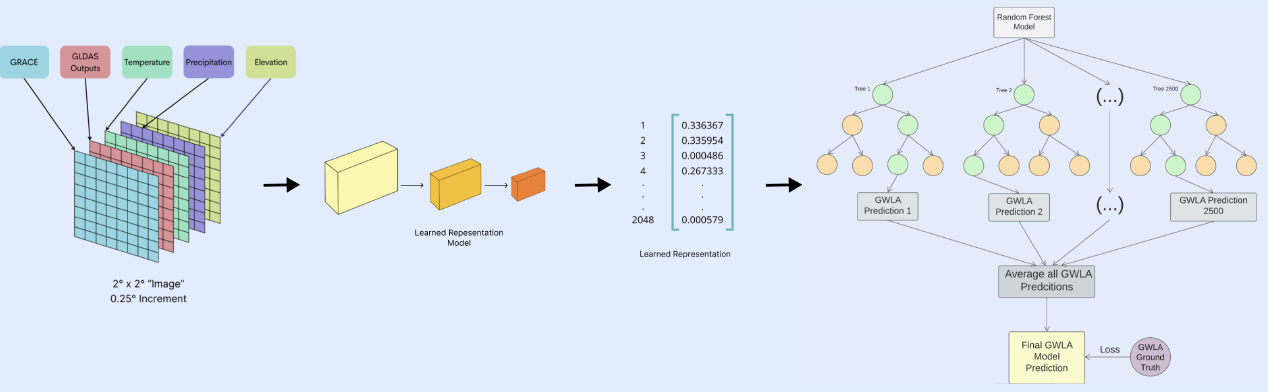
Figure 5. A satellite data “image” is fed into the trained unsupervised representation learning model. The resulting vector is fed into a random forest model that is trained on ground truth data (GWLA) to predict the groundwater